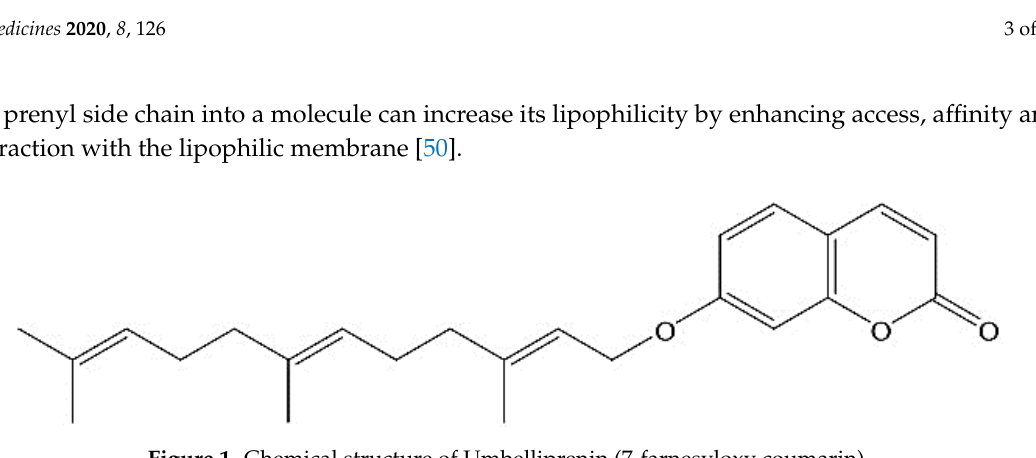
Figure 1. Chemical structure of Umbelliprenin (7-farnesyloxy coumarin).